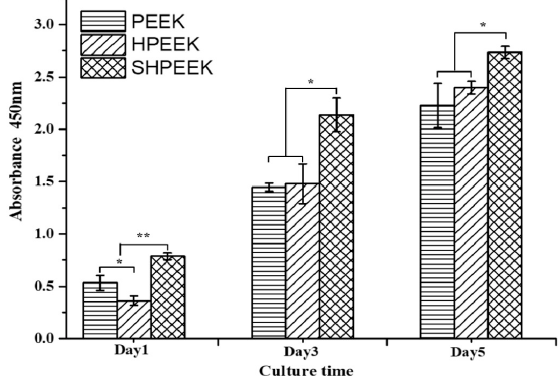
Figure 29. The proliferation of MC3T3-E1 cells on PEEK, HPEEK and SHPEEK scaffolds at different time points. * p < 0.05 and ** p < 0.01. Reproduced from [216] with permission of Elsevier under a